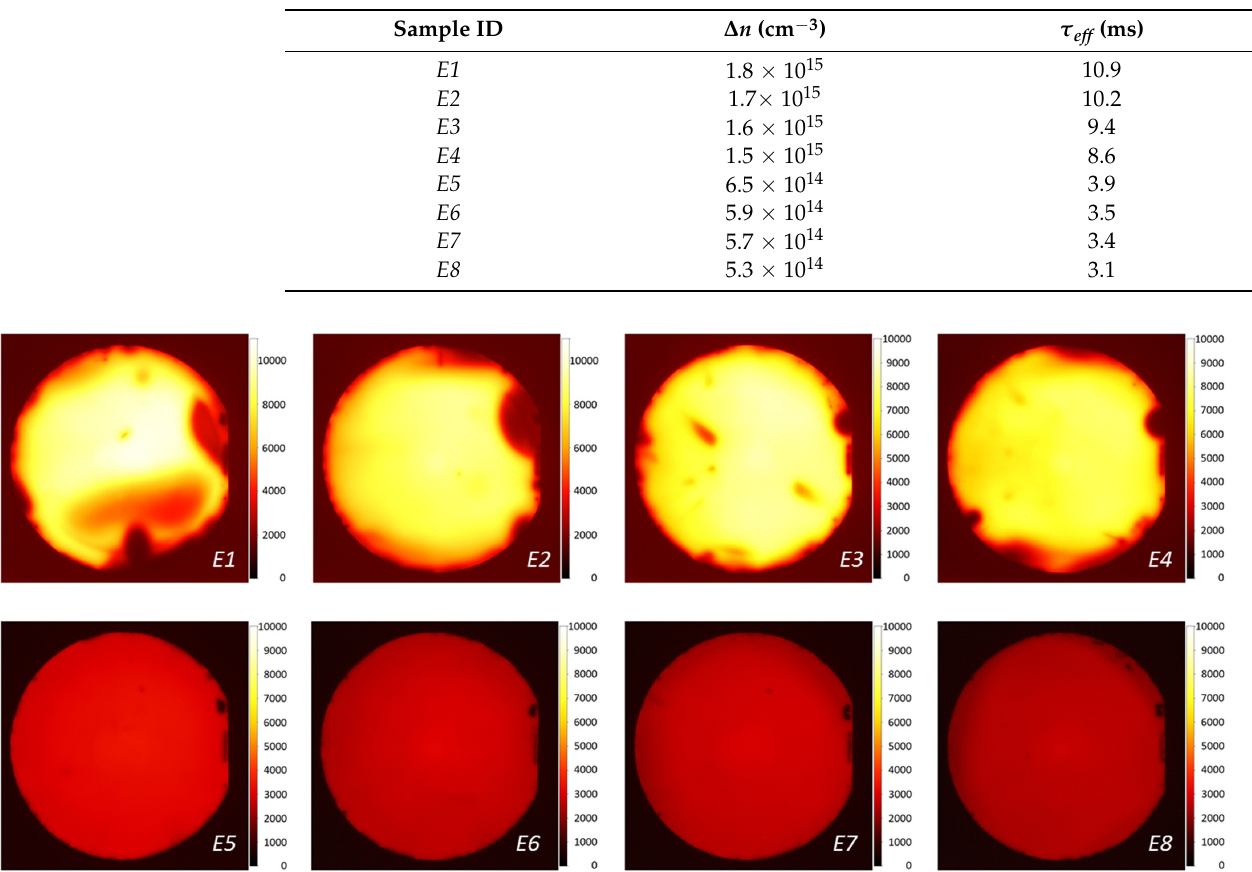
Table 2. Injection level and corresponding lifetime used for calibration of PL images for different samples.